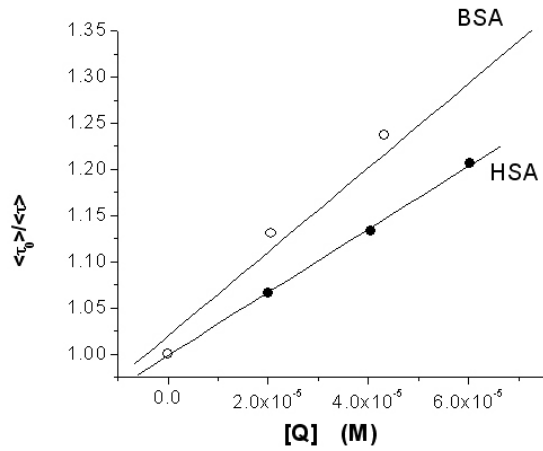
Figure 4. Time resolved Stern-Volmer plots for the dynamic quenching of HSA and BSA in the presence of